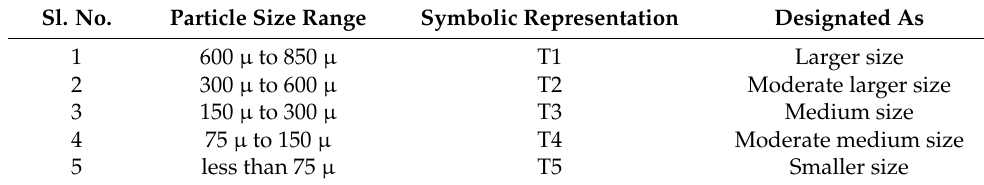
Table 2. Different sizes of dust particles and their designation.